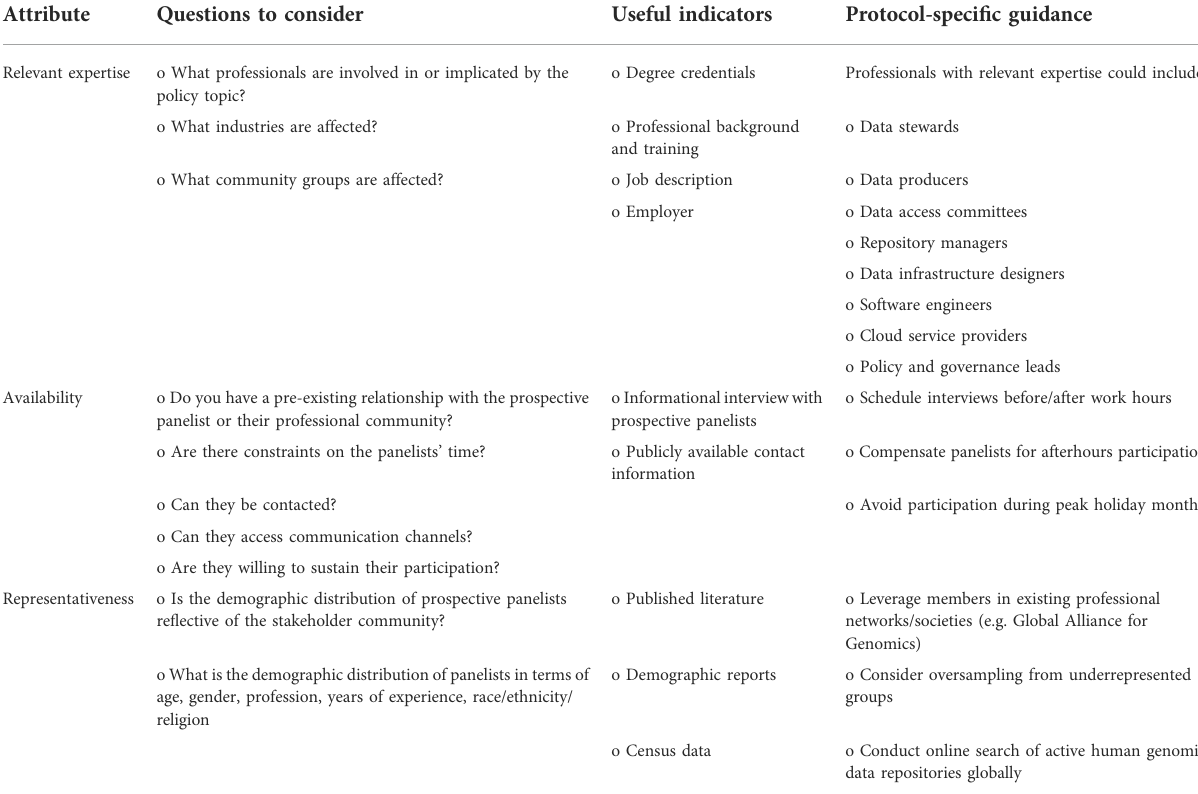
TABLE 4 Practical guidance for planning an expert Delphi panel.